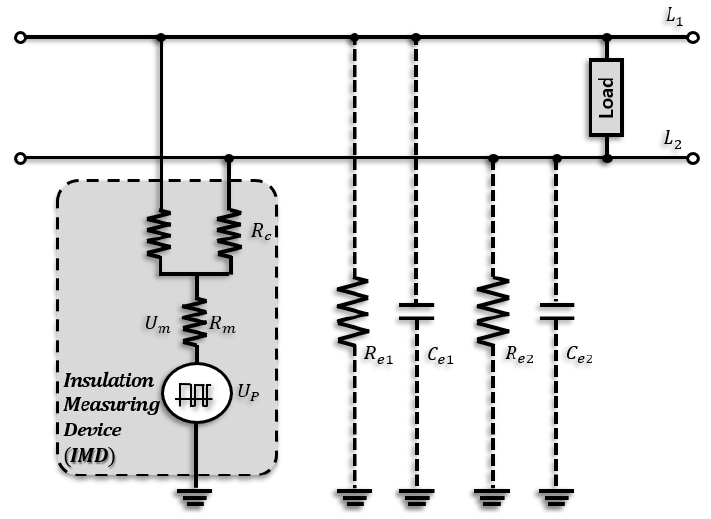
Figure 1. Example of square wave injection type insulation monitoring device (IMD) connected to ungrounded system.